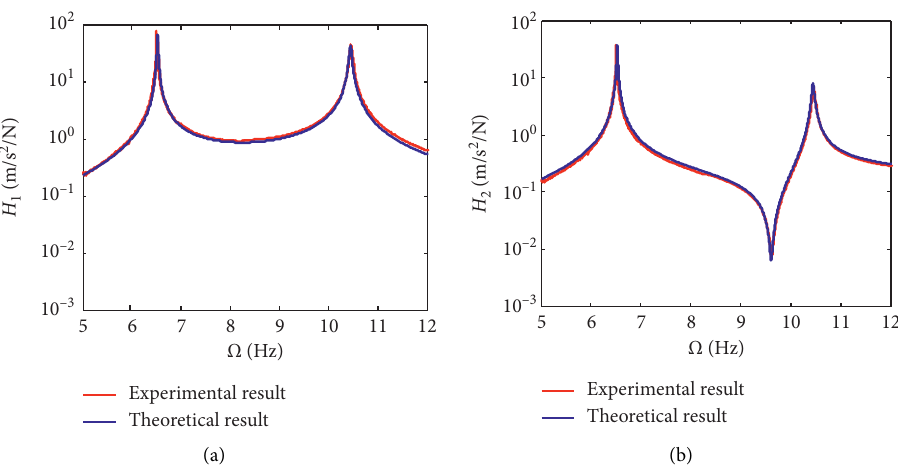
Figure 4: Comparison of the experimental and theoretical results of H